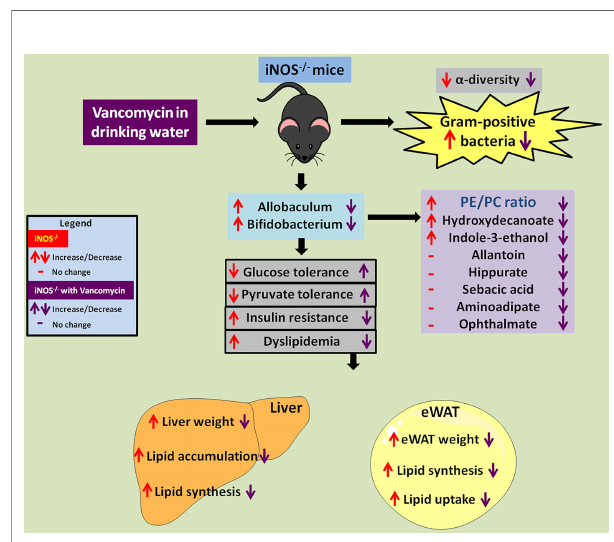
FIGURE 7 | Vancomycin-induced depletion of gram-positive gut bacteria and modulation of associated metabolites rescue the IR and dyslipidemia observed in iNOS − / − mice. Red up or down arrows or dash represents increase, decrease, or no change in iNOS − / − mice in comparison with WT. Violet up or down arrows or dash represents increase, decrease, or no change in vancomycin-treated iNOS − / − mice respectively in comparison with untreated iNOS − / −